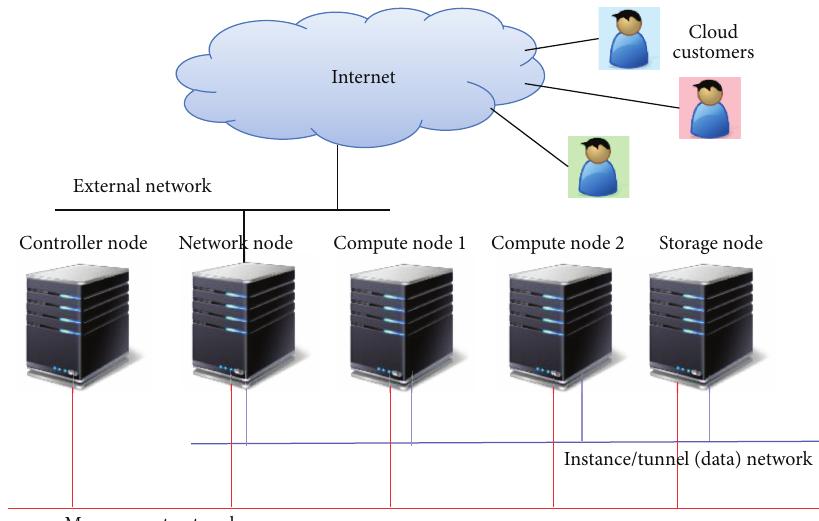
Figure 1: Main components of an OpenStack cloud